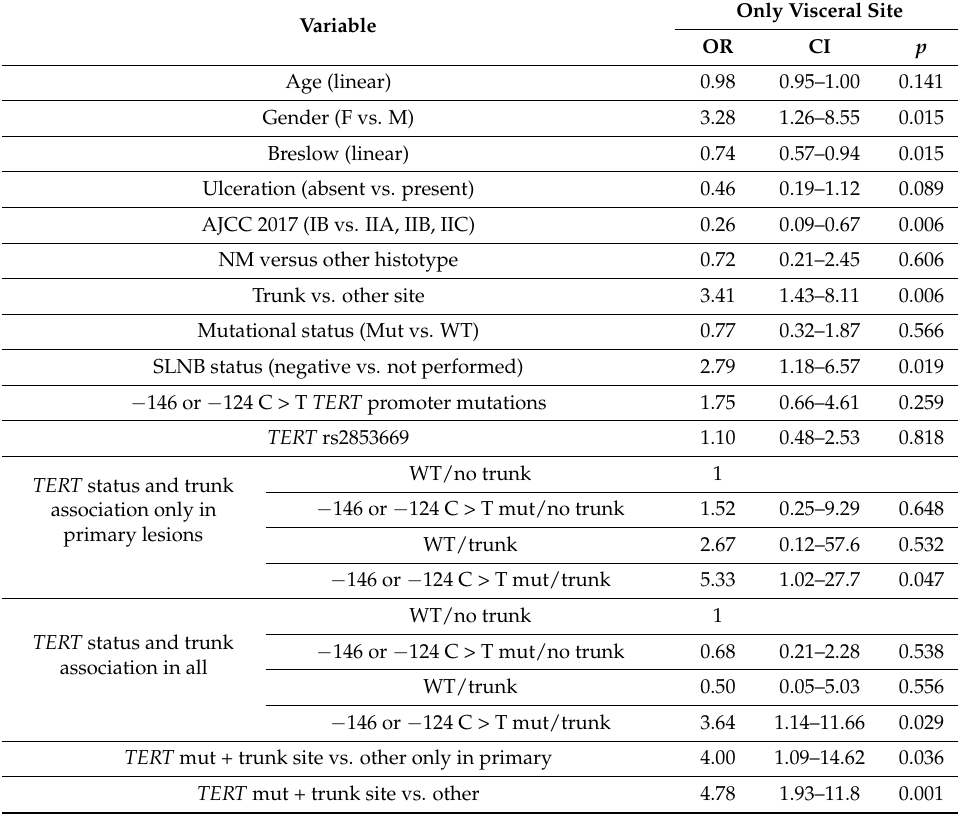
Table 4. Univariate logistic